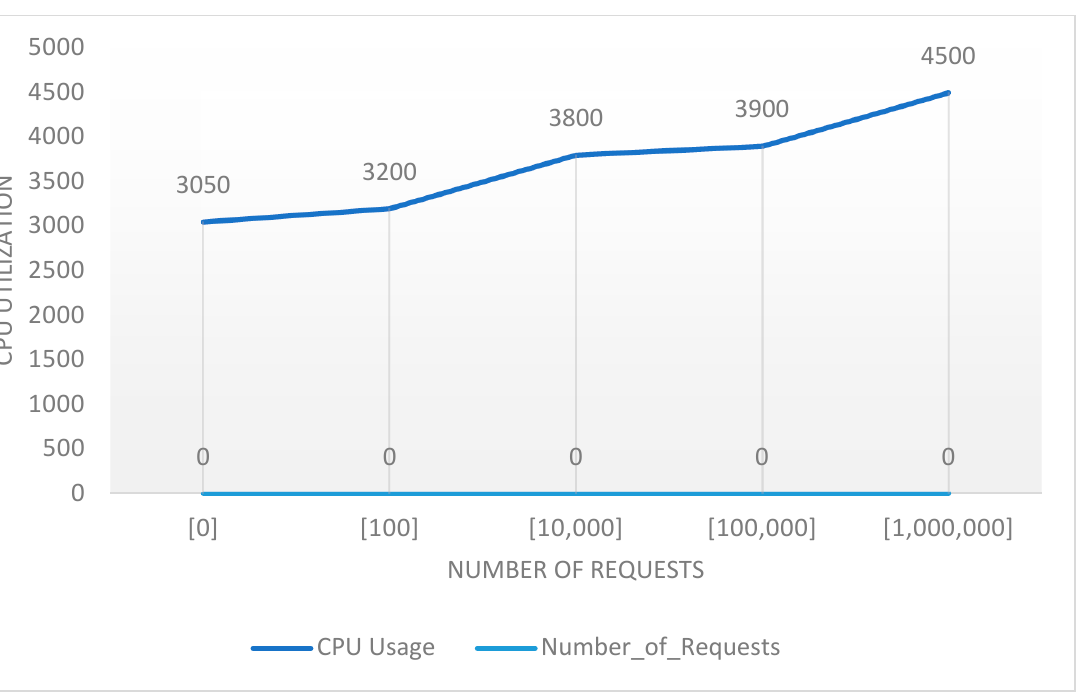
Figure 24. Performance of the scaled system by 3 nodes: memory and transmissions (Rx, and Tx). The network transmission at the transfer side showed tremendous changes, but it was also observed that, at one hundred requests, the graph began to go down to ten thousand, but then increased. 8. Conclusions The implementation of a comprehensive solution for the whole IoT lifecycle was presented in this research. The lifecycle presented fit into four phases: data capture, communication, analysis, and implementation. A generic framework architecture, based on the above layers, was defined in the DevOps paradigm. The architecture complied with the main system requirements of all proposed IoT solutions. The proposed IoT solutions were discussed in the building fire prevention sector, to improve building comfort and security. Different challenges were discussed concerning the scalability, updating, and performance of IoT devices with low computing capabilities.